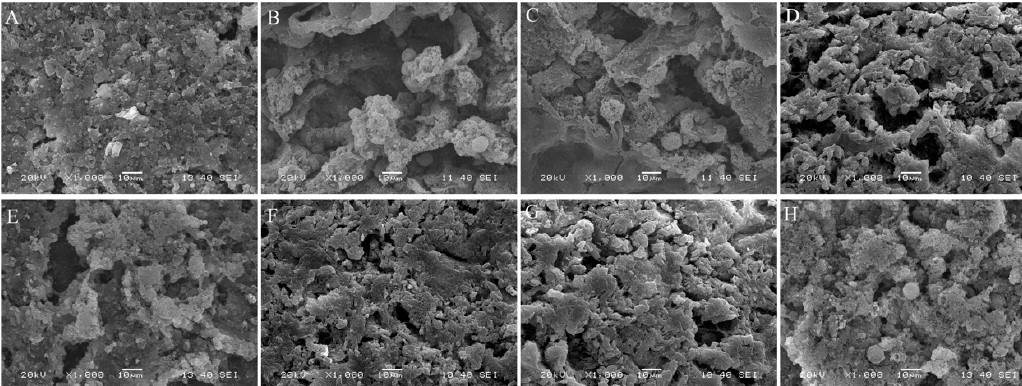
Figure 7. SEM images of mussel muscle tissues treated with the control ( B ), water ( C ) and combined glazing solutions after 90 days of frozen storage, compared with the fresh muscle tissue (( A ), 0 days). ( D ), 0.5% ( w / v ) pullulan; ( E ), AEW pH 4.5; ( F ), AEW pH 6.5; ( G ), 0.015 g/L ClO 2 and 0.5% ( w / v ) pullulan; and ( H ), 0.030 g/L ClO 2 and 0.5% ( w / v ) pullulan.